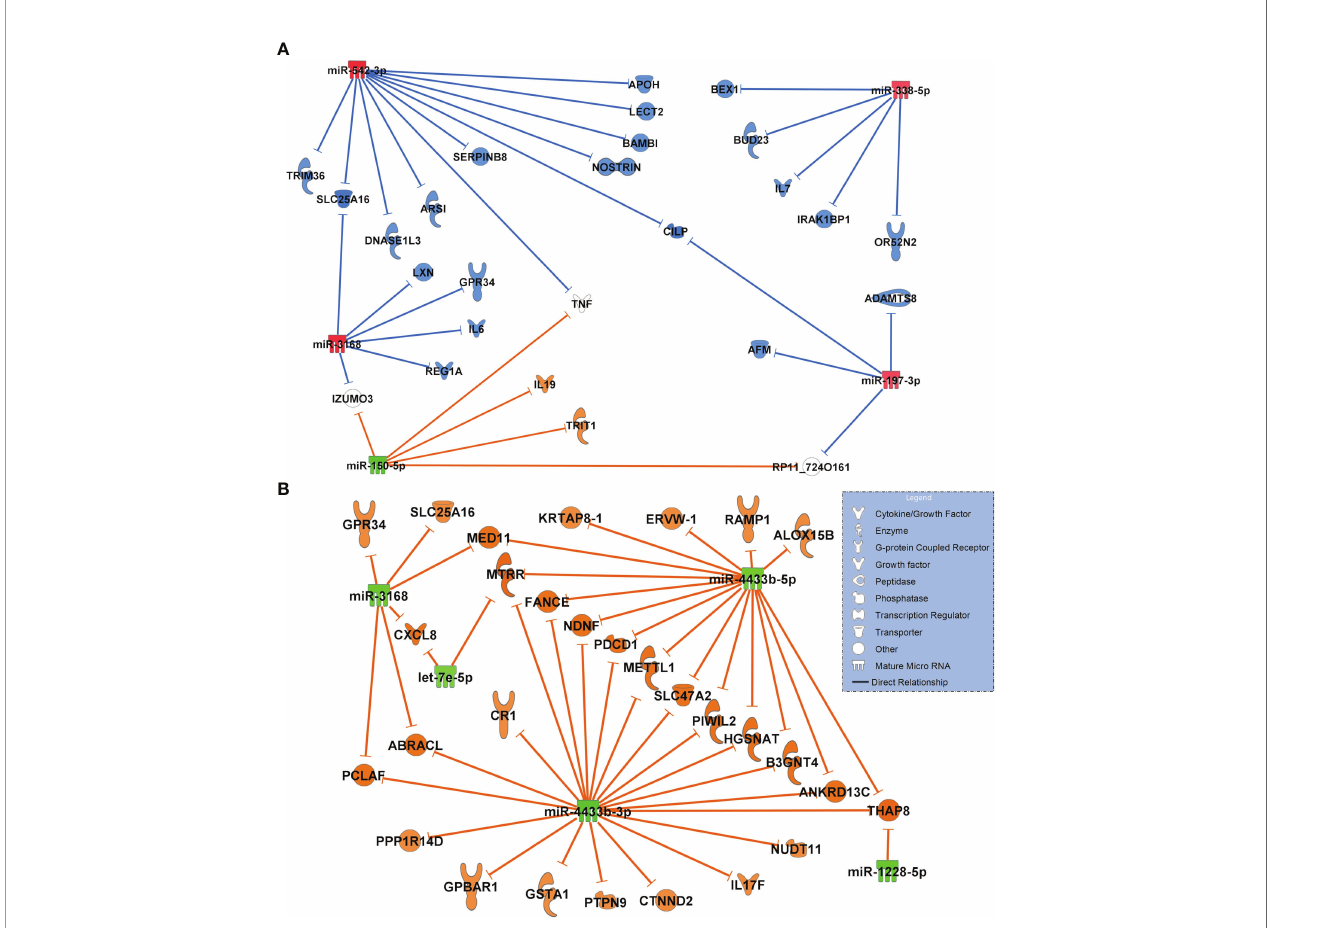
FIGURE 5 | (A) Comparison of the highest differentially regulated miRNAs generated from small RNA sequencing data derived from circulating extracellular vesicles between healthy controls (n=18) and patients with COVID-19 pneumonia (n=15) and their predicted targets by in-silico analysis. Healthy controls were regarded as baseline for calculating log 2 FC and p-adjusted values. (B) Network of COVID-19 pneumonia patients (baseline) versus patients with COVID-19 ARDS (n=15). For identi fi cation of miRNAs, log2FC expression values were set to ≥ 1.8 or ≤ -1.8 and only highly predicted or experimentally observed relationships are shown. Signi fi cantly upregulated miRNAs are presented in red and their predicted and presumably inhibited targets in blue. Downregulated miRNAs are shown in green, and their activated targets are depicted by orange colour. The legend inserted into the graph illustrates the type of target molecules according to the symbols used in the